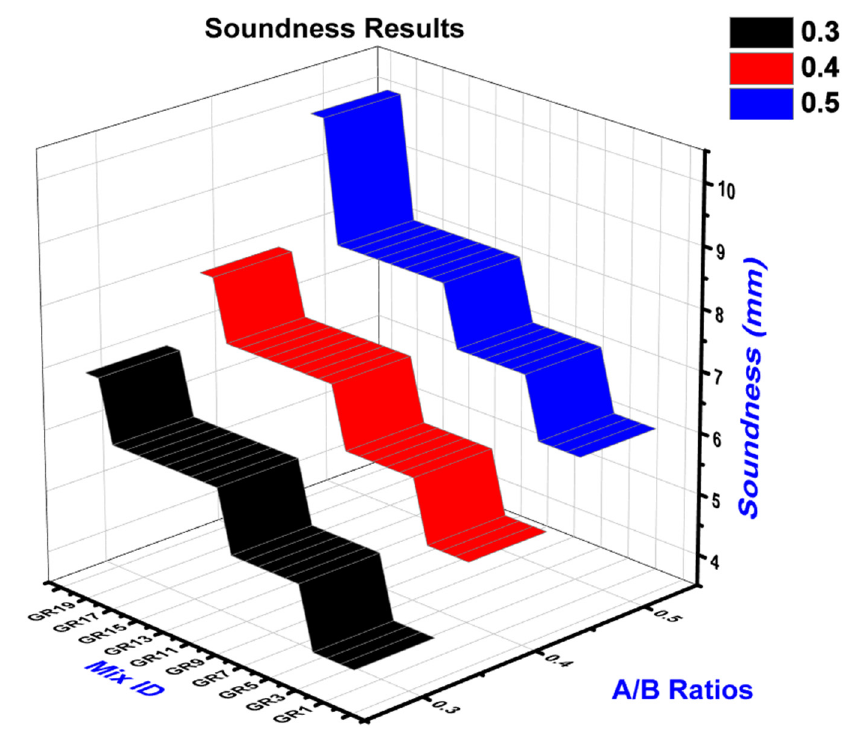
Figure 4. Soundness tests for various A/B ratios.